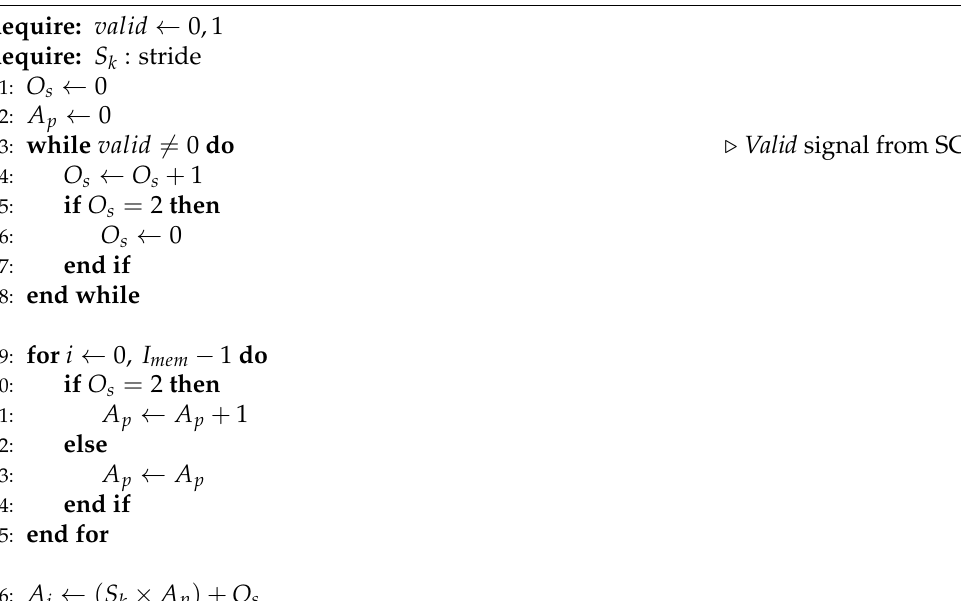
Algorithm 1 AGU for input image